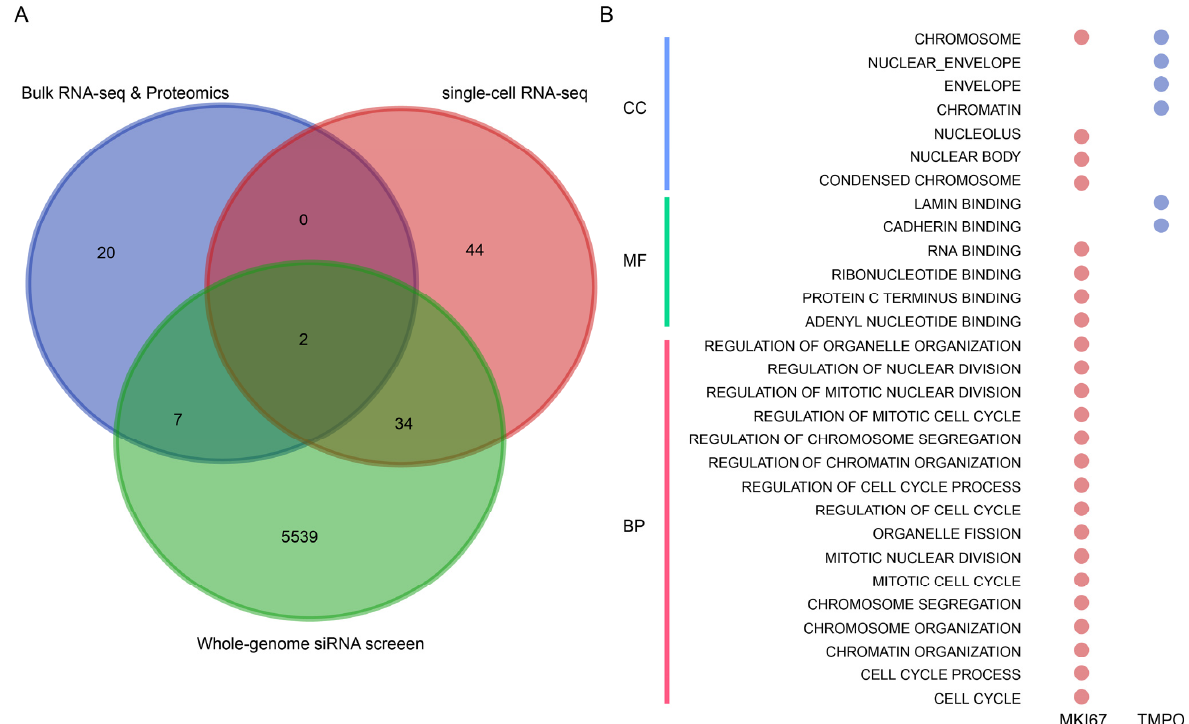
Figure 8. Identification of hub genes involved in BKPyV infection of PT . ( A ) Multi-omics to identify the hub genes in PT with BKPyV infection. Bulk RNA-seq and proteomics: identified the different expression genes that were altered in infected PT using bulk RNA-seq and quantitative proteomics [32]; single-cell RNA-seq: studied the genes covaried with BKPyV transcript levels via single-cell transcriptomic analysis [33]; whole-genome siRNA screen: explored essential genes for BKPyV infection in PT using the whole-genome RNA interference screen [34]. ( B ) The GO terms of MKI67 and TMPO.